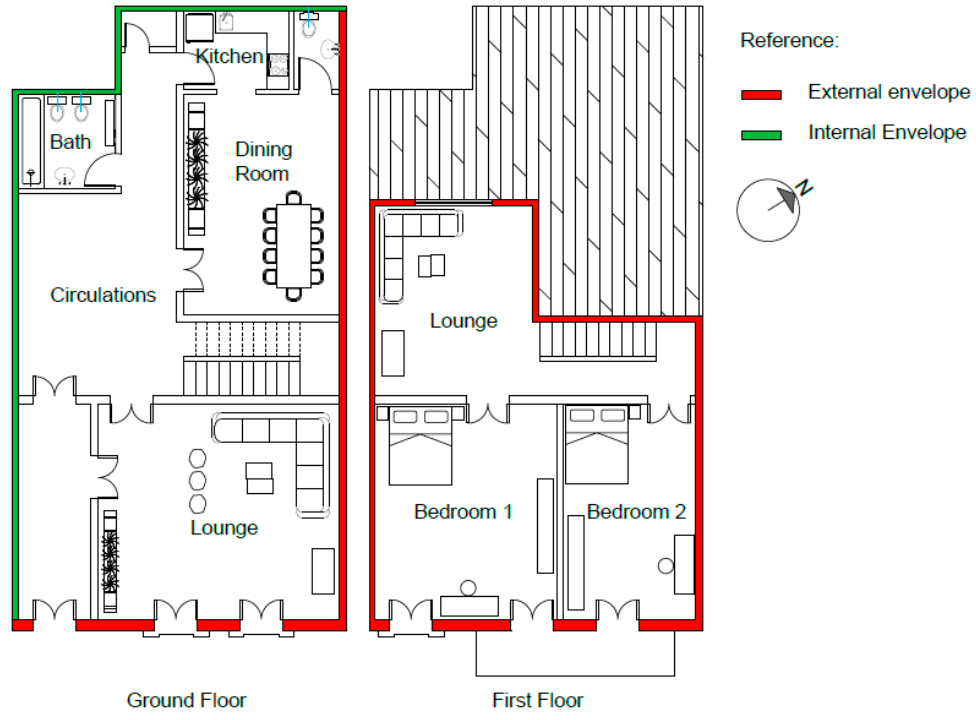
Figure 2. Architectural blueprints and thermal envelope characterisation of the case Figure 2 . Architectural blueprints and thermal envelope characterisation of the case study. Table 2. Input parameters set for the simulations. The occupation density (m 2 /person), the minimum fresh air (l/s-person), the target illuminance (Lux), the internal gains (W/m 2 ) and the occupation schedules are shown.